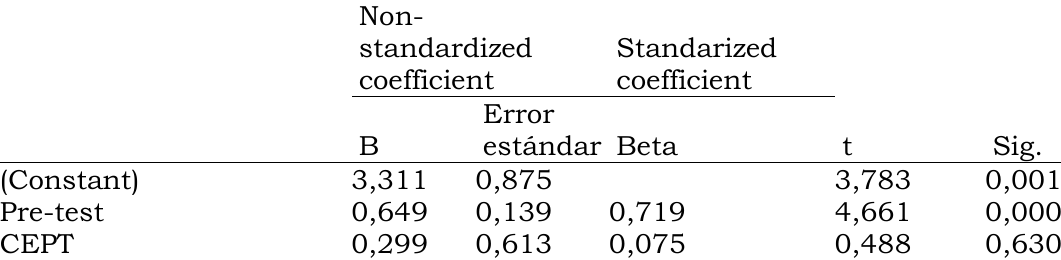
Table 3. The result of